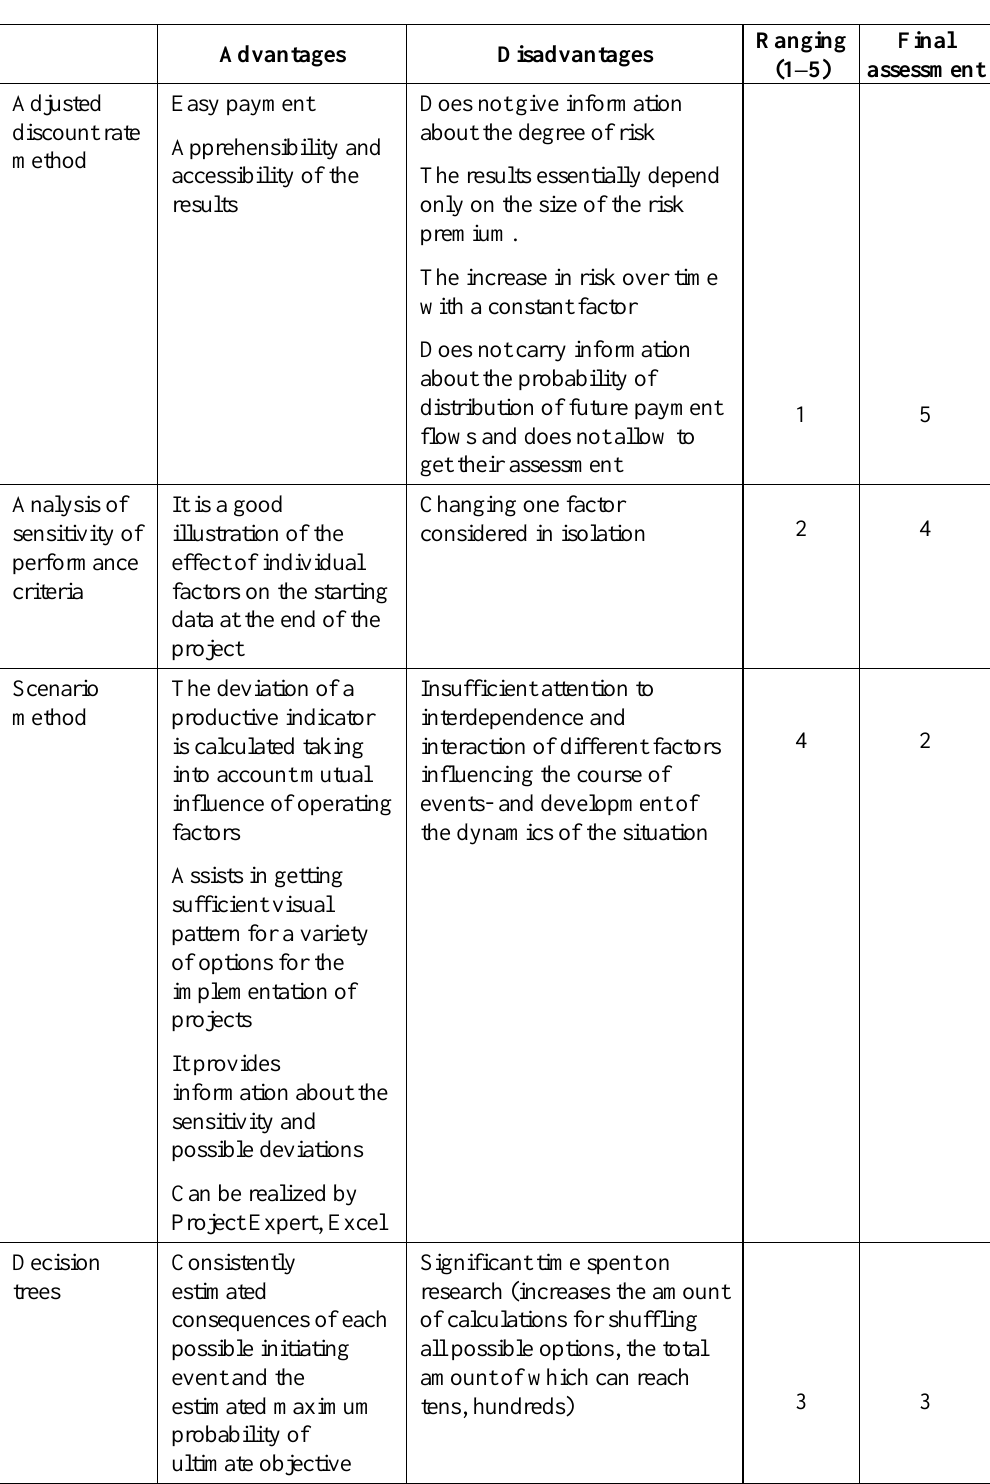
Table 1. Comparative Features of Methods of Risk Analysis